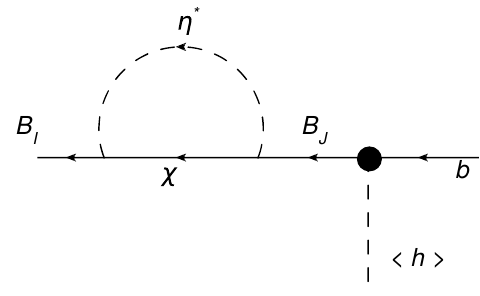
Figure 4 . One loop diagram contributing to the b → B